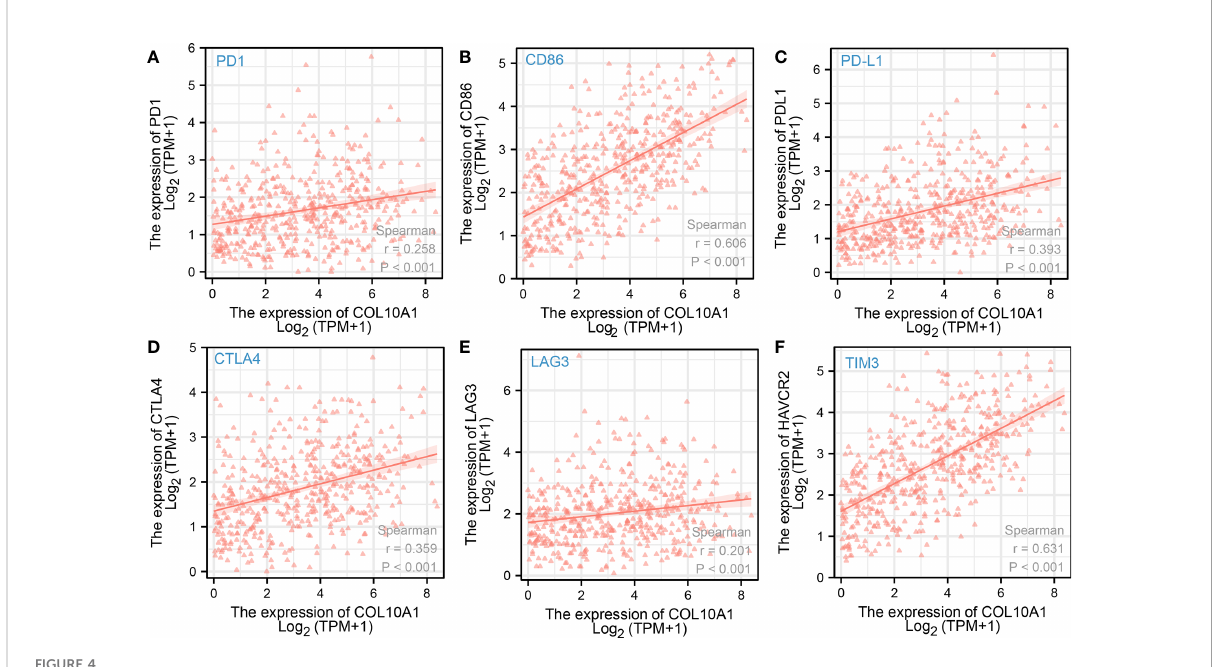
FIGURE 4 Spearman correlation test of COL10A1 expression levels and expression of immune checkpoint molecules (A) PD1, (B) CD86, (C) PD-L1, (D) CTLA-4, (E) LAG3, and (F) TIM3.